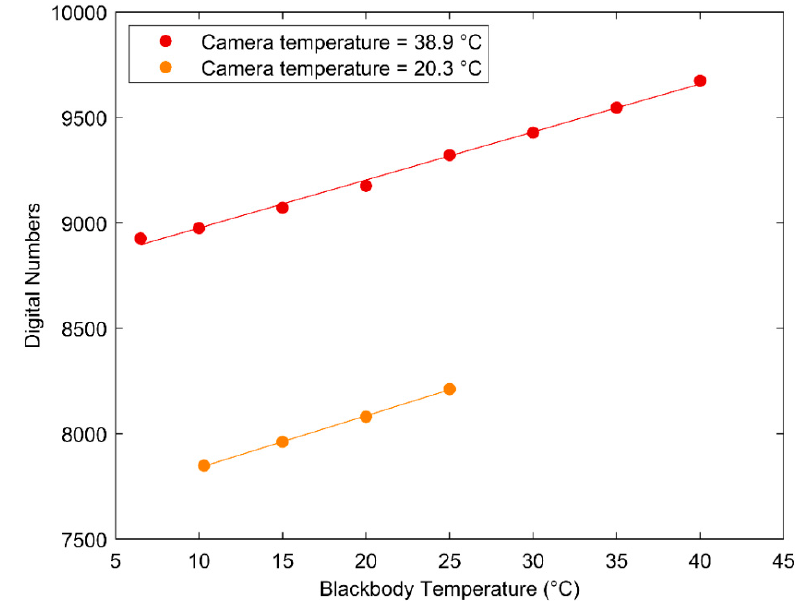
Figure 3. Blackbody curves for the Vue Pro conducted at a room temperature of 21 °C (camera temperature = 38.9 °C, σ = 0.3 °C) and in an incubation chamber at 10 °C (camera temperature = 20.3 °C, σ = 0.1 °C). Error bars showing ± σ DN for the 20 images recorded at each blackbody temperature step are not visible as σ < 3.4 DN.